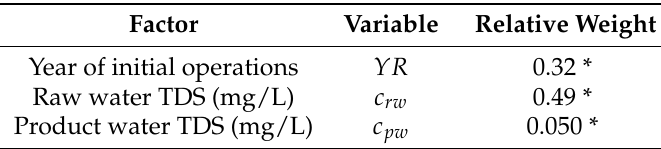
Note: * relative weight is statistically